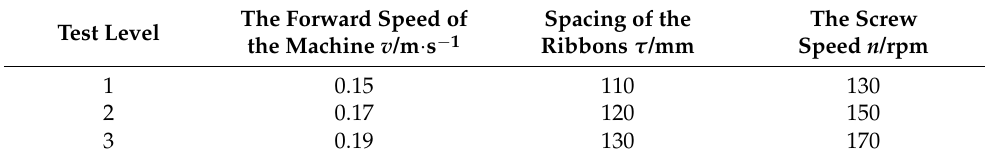
Table 2. Factors and levels of orthogonal